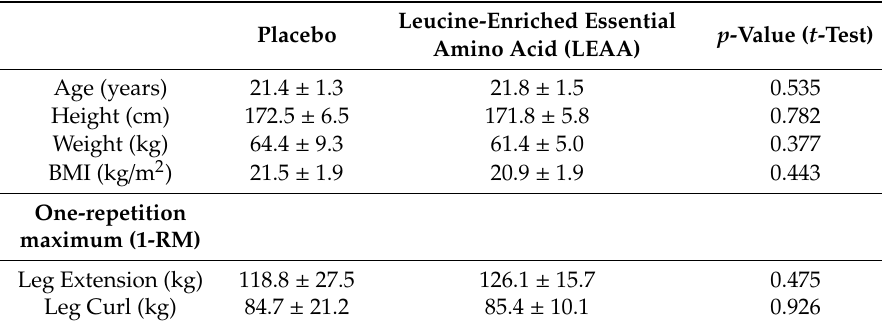
Table 1. Subject